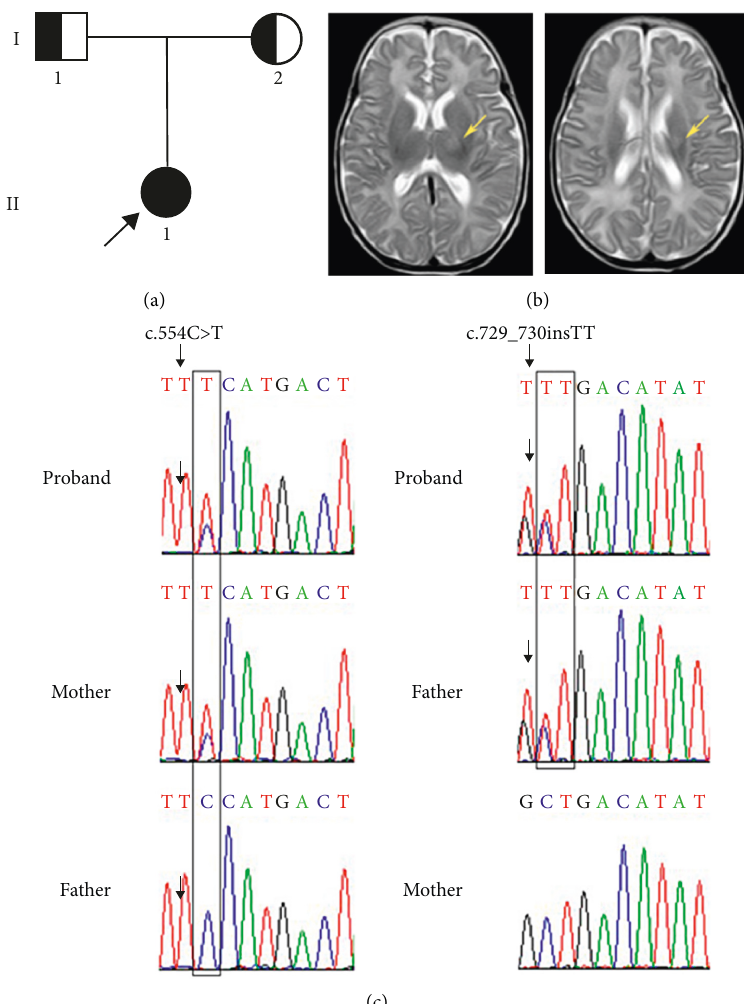
Figure 1: Clinical summary for the MMA family. (a) Family pedigree. An unrelated natural couple who gave birth to the affected child (black arrow denotes the proband). (b) The patient’s axial brain MRI (yellow arrowheads show small patches of abnormal signals in the dorsal thalamic region of the left basal ganglia). (c) Sequence analysis of the human MMUT gene. A c.554C > T mutation of the MMUT gene was identified in the proband, and her mother was an asymptomatic heterozygous carrier. Arrows indicate the positions of the rare mutations. A c.729_730insTT mutation of the MMUT gene was identified in the proband, and her father was an asymptomatic heterozygous carrier. Arrows indicate the positions of the mutations.